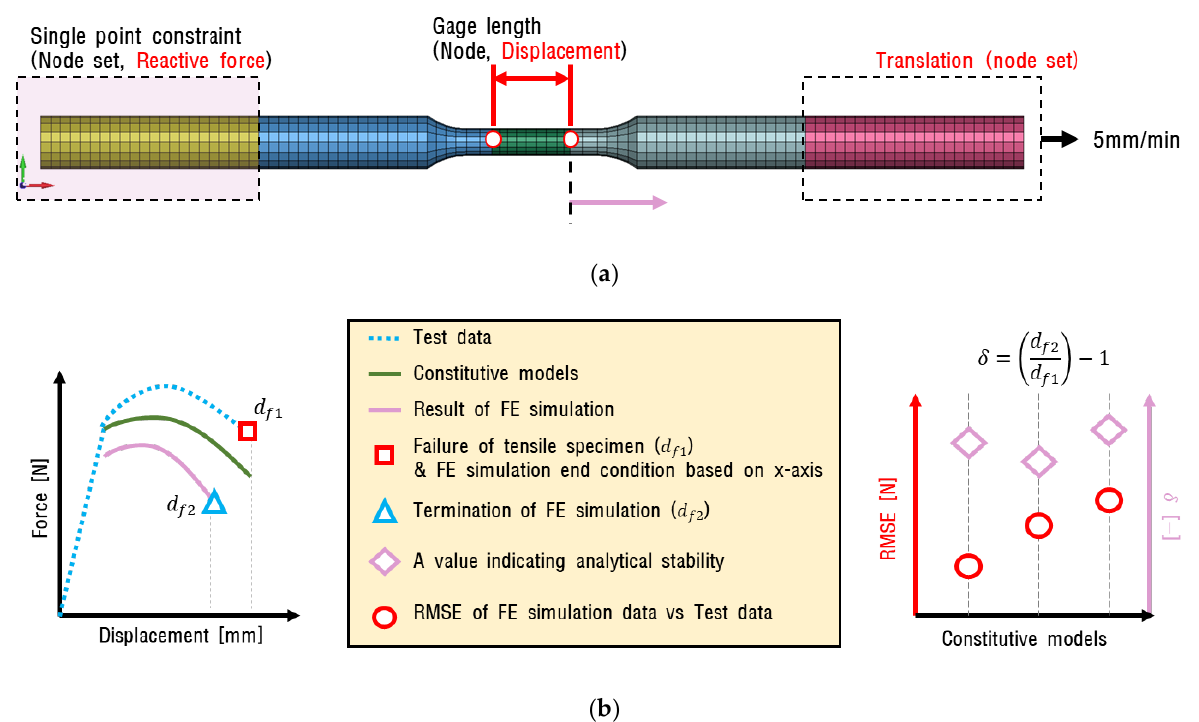
Figure 8. FE model of tensile specimen: ( a ) Finite element model and boundary condition; ( b ) Concept of FE simulation results.